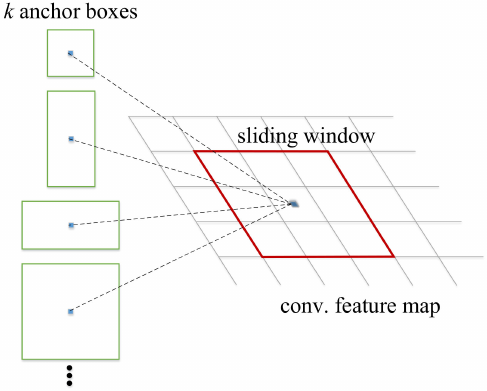
Figure 8. Illustration of anchor boxes.